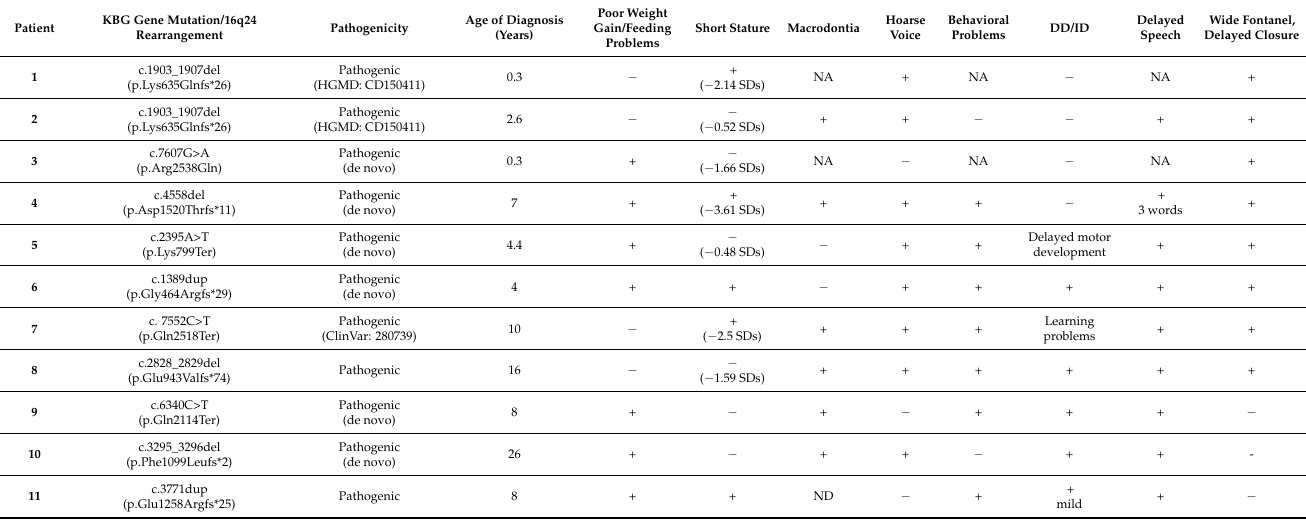
Table 1. Clinical characteristics of KBG